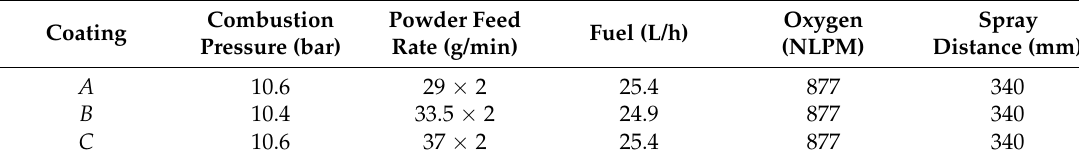
Table 1. Spray parameters of the three